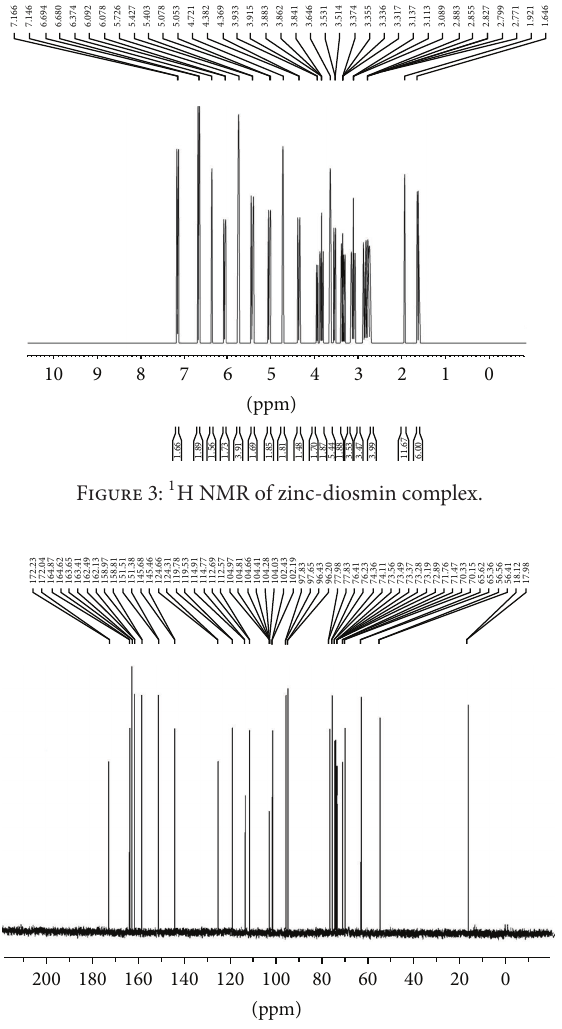
Figure 4: 13 C NMR of zinc-diosmin complex.